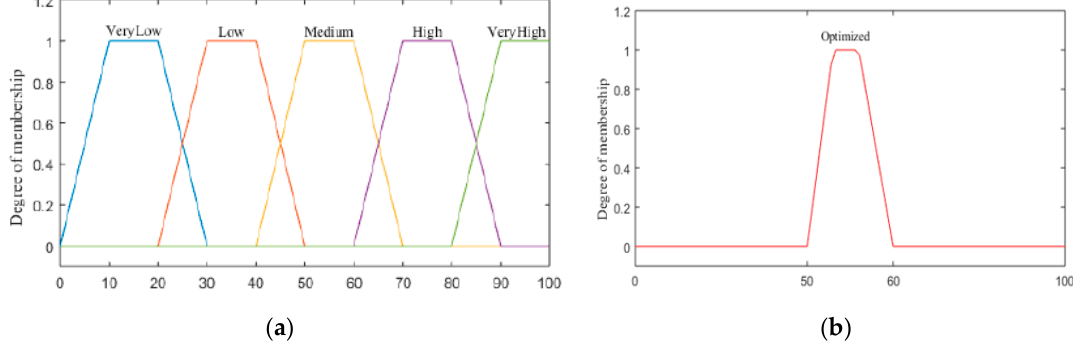
Figure 6. Membership function graphs for humidity level (%). ( a ) Current humidity level. ( b ) Optimized humidity level.